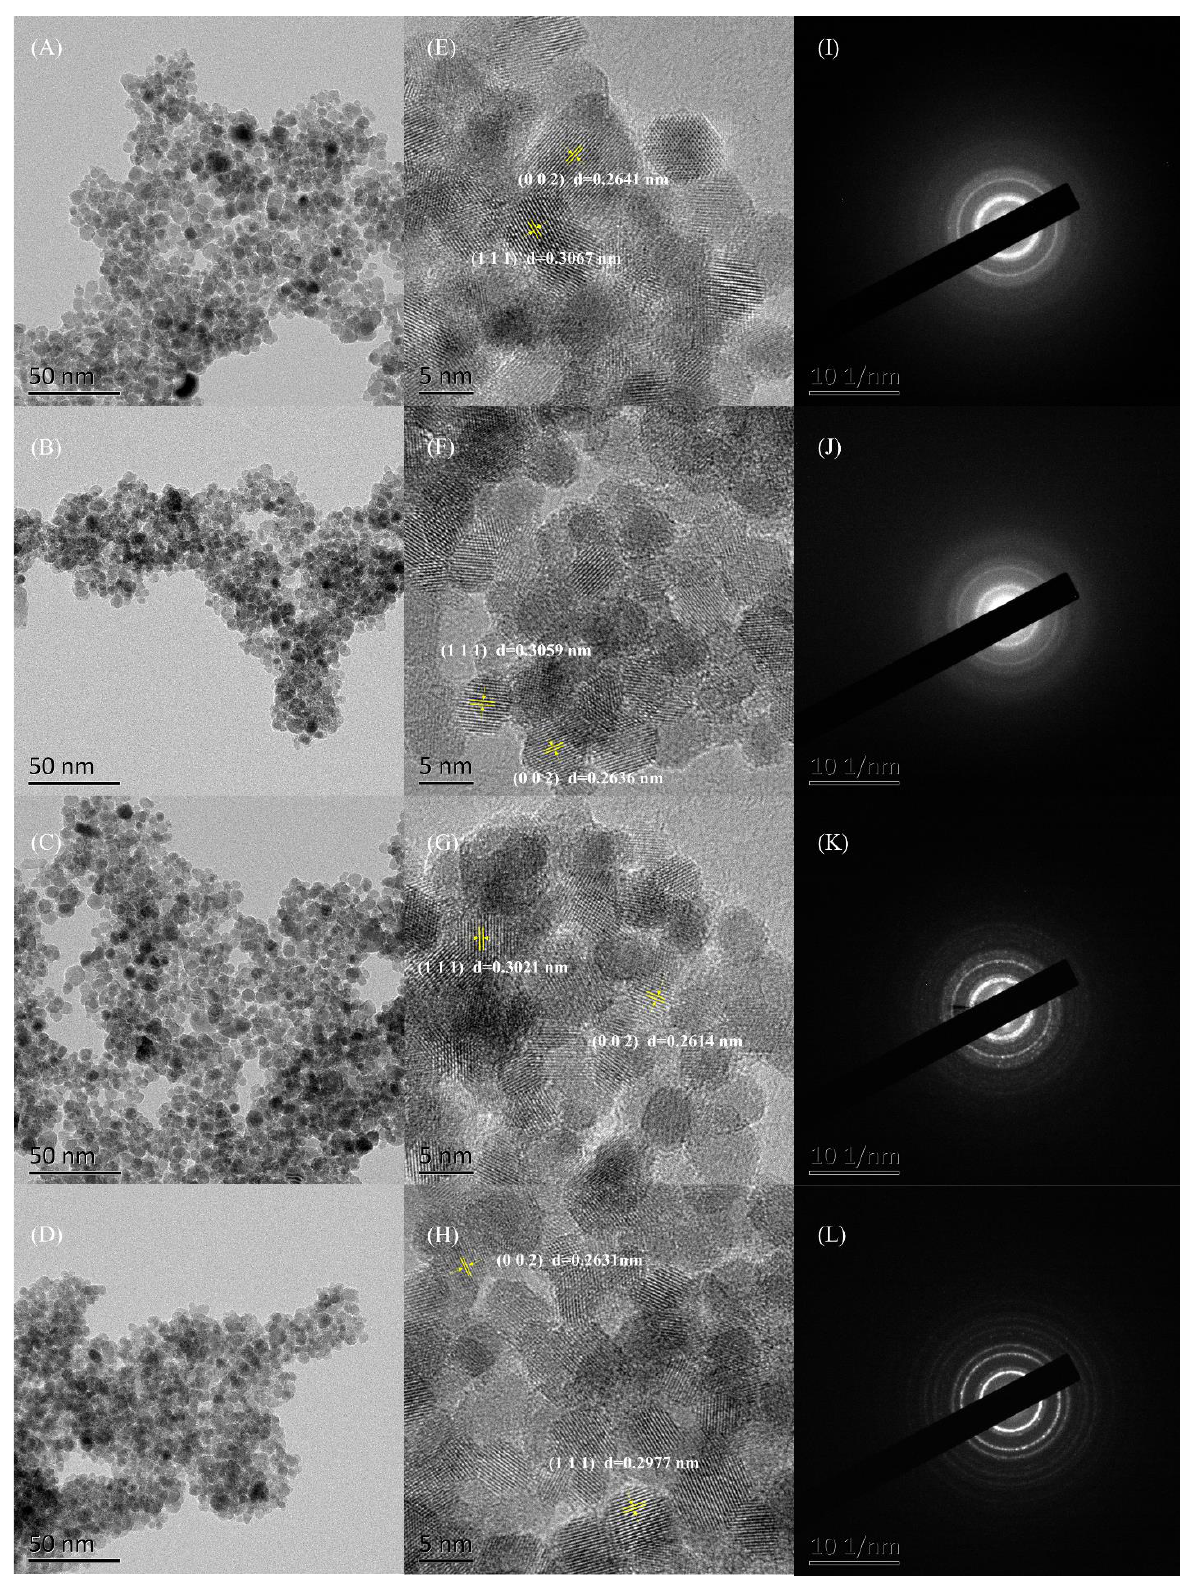
Figure 6. ( A – D ) TEM images, ( E – H ) HR-TEM images and ( I – L ) SAED patterns for the CZ nanopar- ticles.